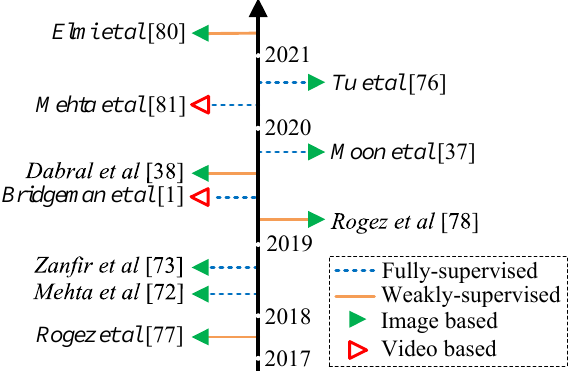
Figure 6. Chronological overview of some of the most relevant multi-person 3D pose estimation